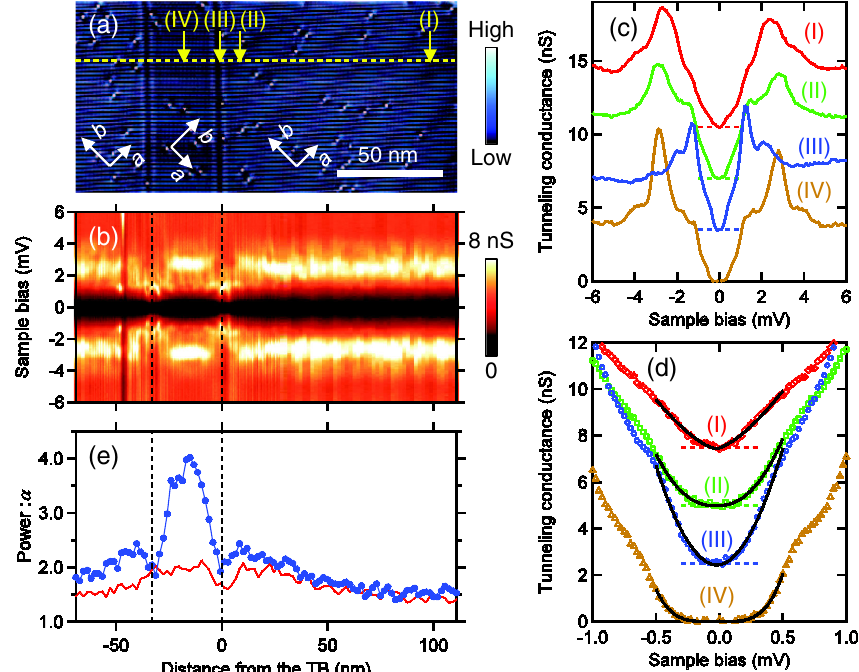
95 mV and I 10 pA. (b) Intensity plot of g ð r ; E Þ s ¼ þ t ¼ 20 mV, I 100 pA, and V 0 . 05 mV . Spectroscopic measurements are done at 0.4 K. s ¼ þ t ¼ mod ¼ rms 20 mV, I 100 pA, and V 0 . 05 mV . (d) High- s ¼ þ t ¼ mod ¼ rms 10 mV, I 100 pA, and V 0 . 025 mV . s ¼ þ t ¼ mod ¼ rms